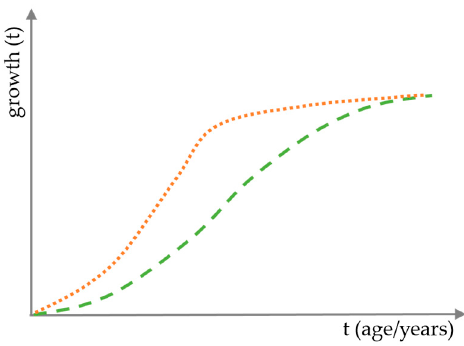
Figure 11. Schematic diagram of tree increment growth over time (t). The green dashed line represents the schematic growth before 1980; the orange dotted line shows accelerated increment growth after 1980.